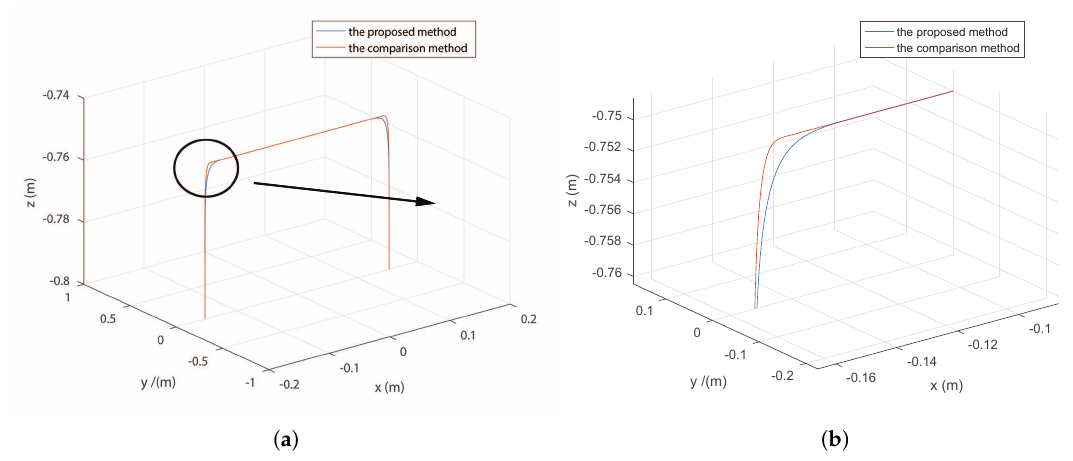
Figure 4. The path of the two approaches. ( a ) The entire path, ( b ) the local path.